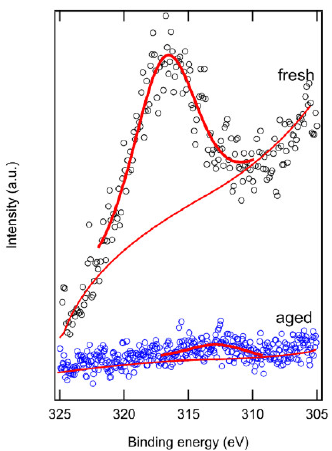
Figure 8. XPS spectra on platinum 4d5/2 lines measured from the diesel oxidation catalyst. While Shirley background subtraction has been used in the analysis, the background lines in the images have been drawn to guide the eye.